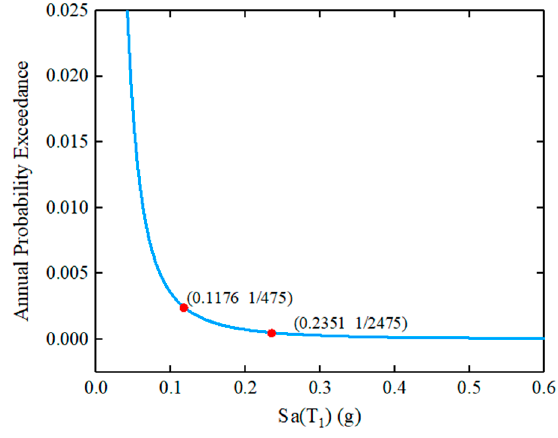
Figure 20. Seismic hazard curves of the novel SCPC frame.